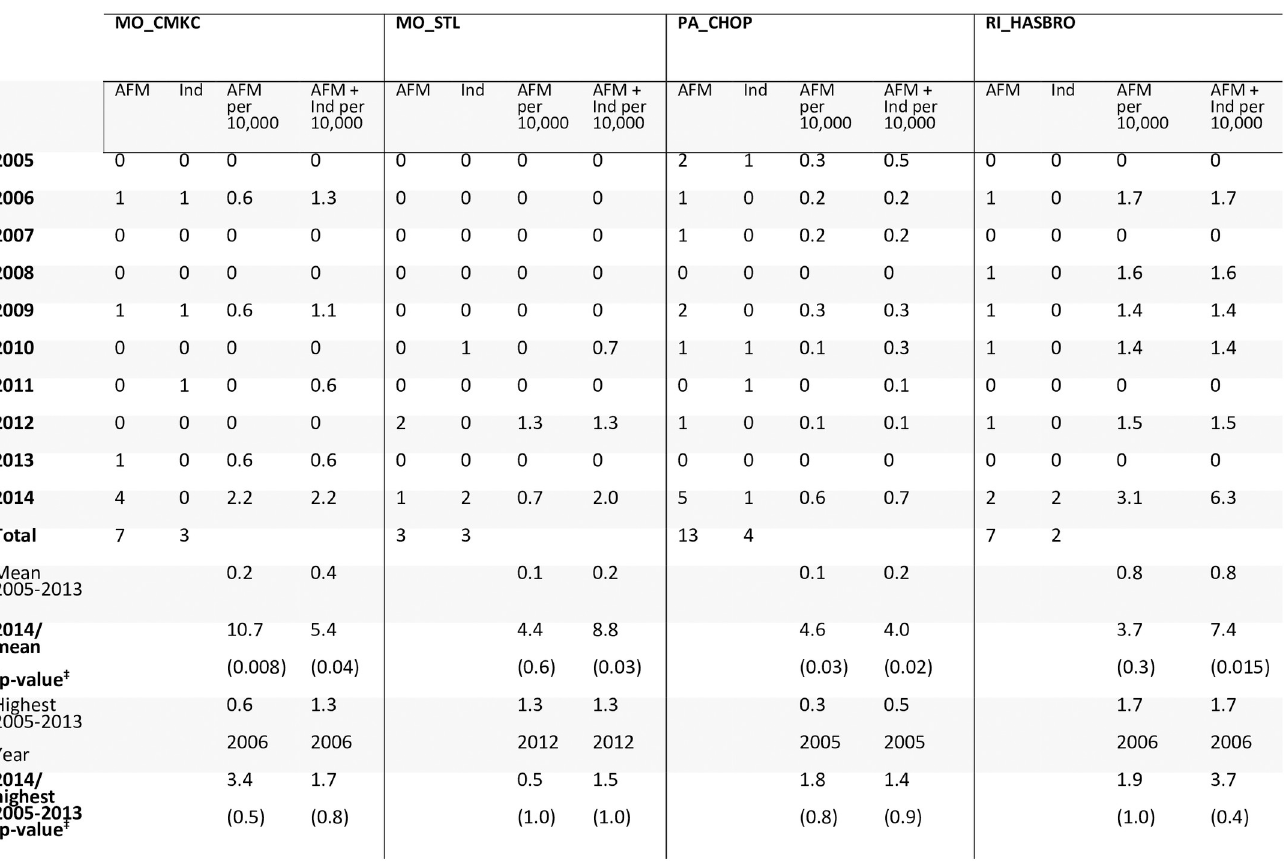
PLOS ONE | https://doi.org/10.1371/journal.pone.0228671 February 13,